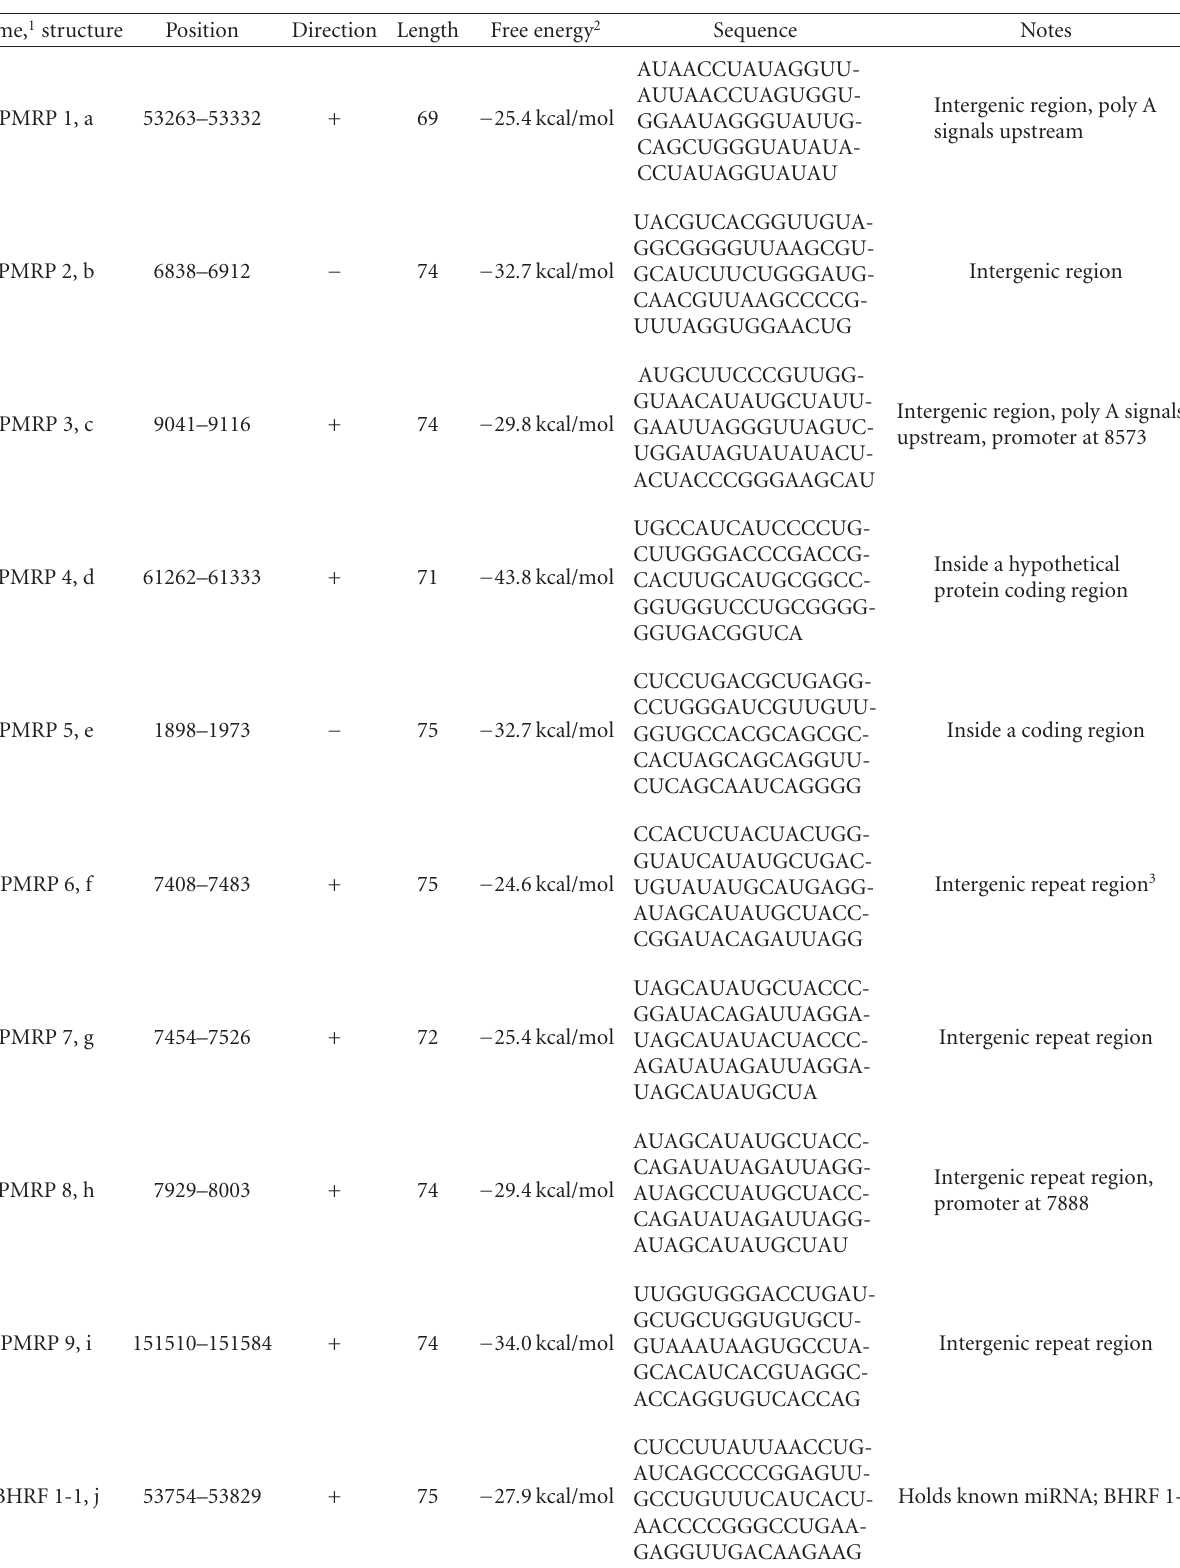
Table 2: Computationally predicted miRNA precursor candidates from the Epstein-Barr virus (this study), ranked according to our criteria. The free-energy estimates were computed by the online mfold [37] version of December 2004. All predicted secondary structures can be found, according to the given letter, in Figure